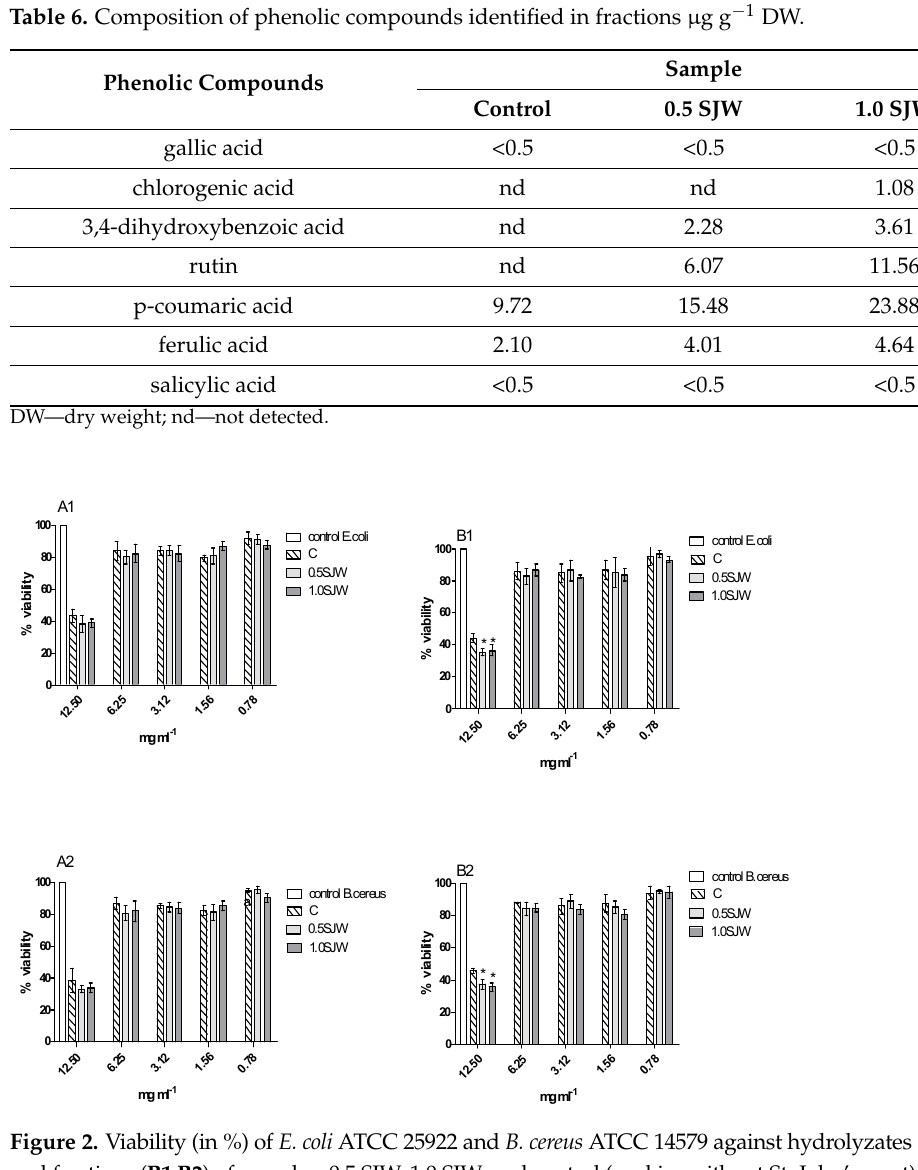
Table 6. Composition of phenolic compounds identified in fractions µg g − 1 DW.